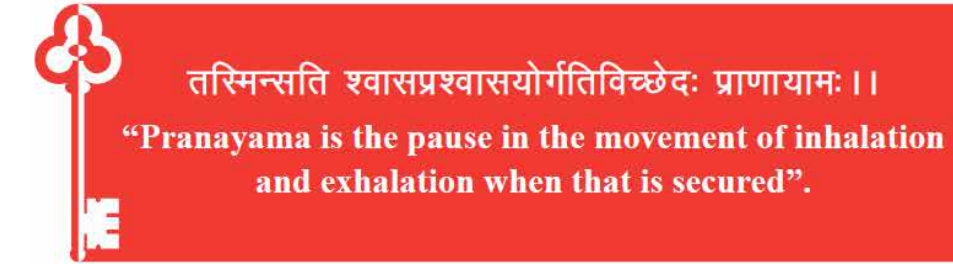
Figure 1. The actual pranayama is kumbhaka, the period of breath retention.